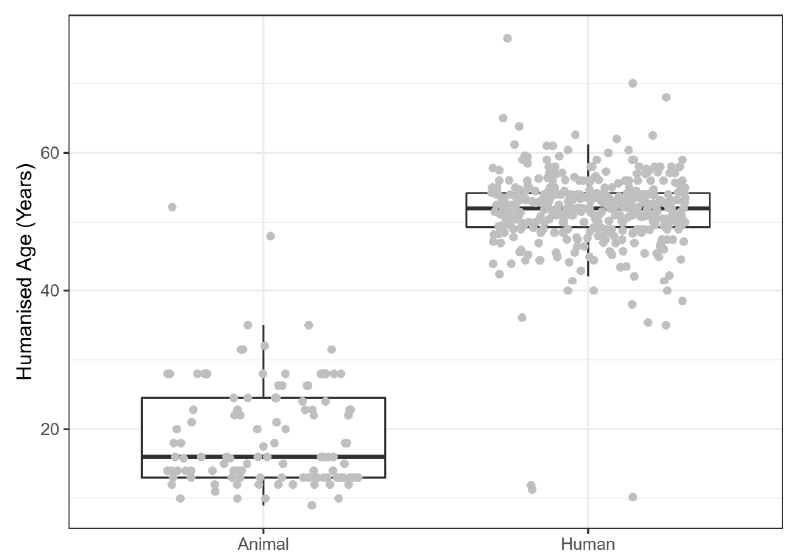
Figure 10. (Humanised) age in years in animal and human studies.